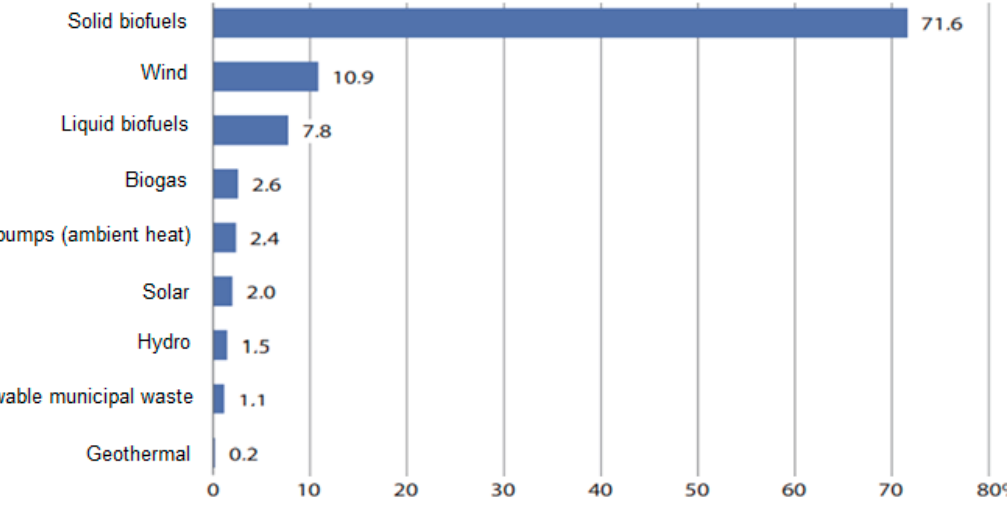
Figure 2. Production of energy from renewable sources by carriers in Poland in 2020. Source: Renewable energy in 2021, CSO, Warsaw, 2022.